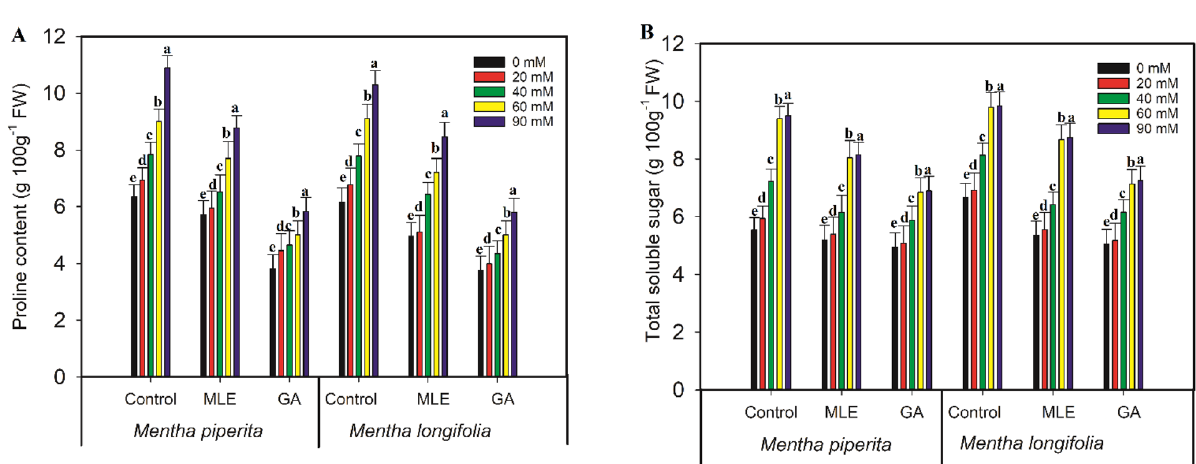
Figure 2. Effect of MLE ( Moringa oleifera ) and GA ( Ulva intestinalis ) on proline ( A ) and total soluble sugar ( B ) content in the Mentha species under salt stress (0 mM, 20 mM, 40 mM, 60 mM, 90 mM). The data displayed are the means (± SE) of three replicates, and bars of dissimilar letters differ significantly at the p ≤ 0.05